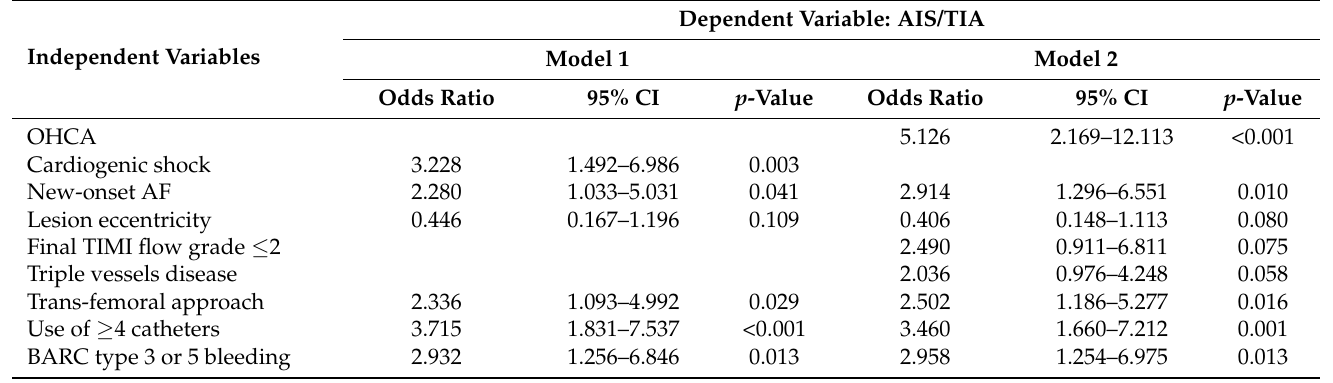
Table 4. Multivariate stepwise logistic regression models to investigate the factors associated with